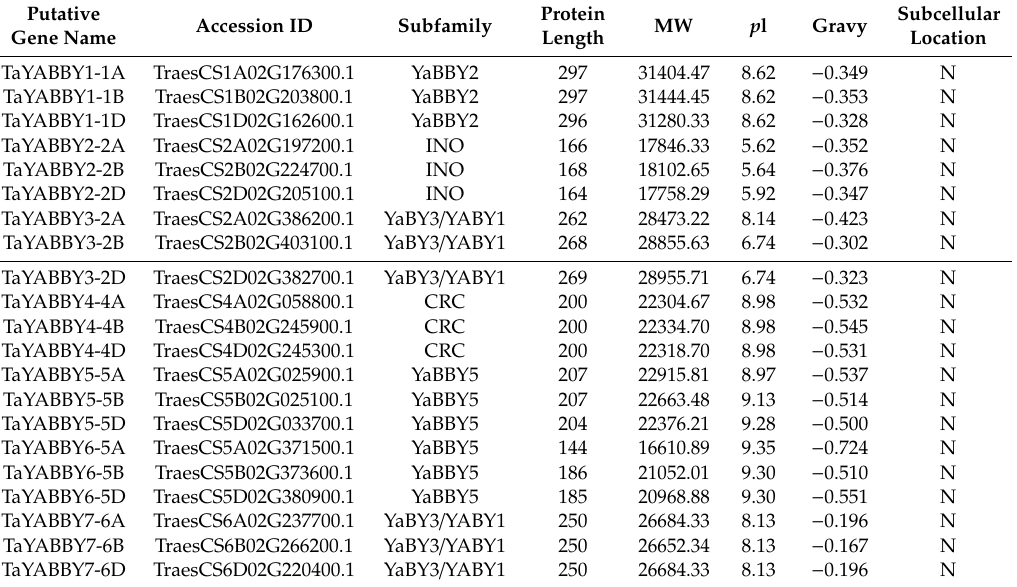
Table 1. The gene and protein features of TaYABBY-gene